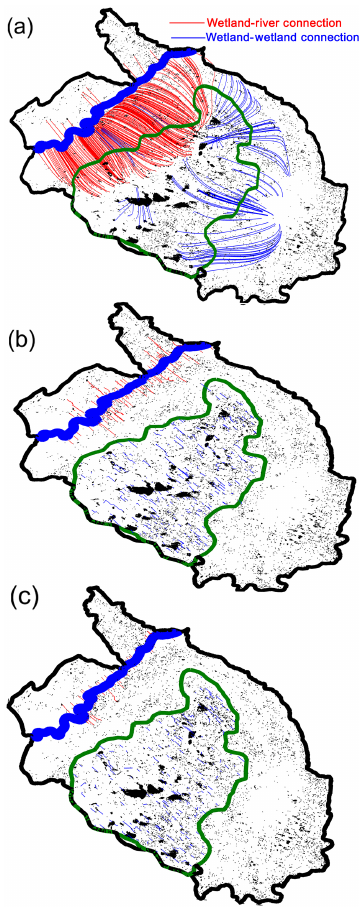
Figure 5. Hydrologic connectivity among wetlands (blue lines) and between wetlands and the North Saskatchewan River (red lines). (a) Map of subsurface connections; only particles released from recharge wetlands located in the moraine and reaching the Beaver- hill Lake and discharge wetlands (blue lines) and particles dis- charged into the North Saskatchewan River from recharge wetlands (red lines) are shown. (b) Map of surface connections for the pe- riod from 1 April to 1 August 2013, when the largest net surface water fluxes since 2000 occurred. (c) Map of surface connections for the period from 1 April to 1 August 2009, when the smallest net surface water fluxes since 2000 occurred. Only surface connections between wetlands and the North Saskatchewan River (red lines), and connections among wetlands within the Moraine (blue lines) are